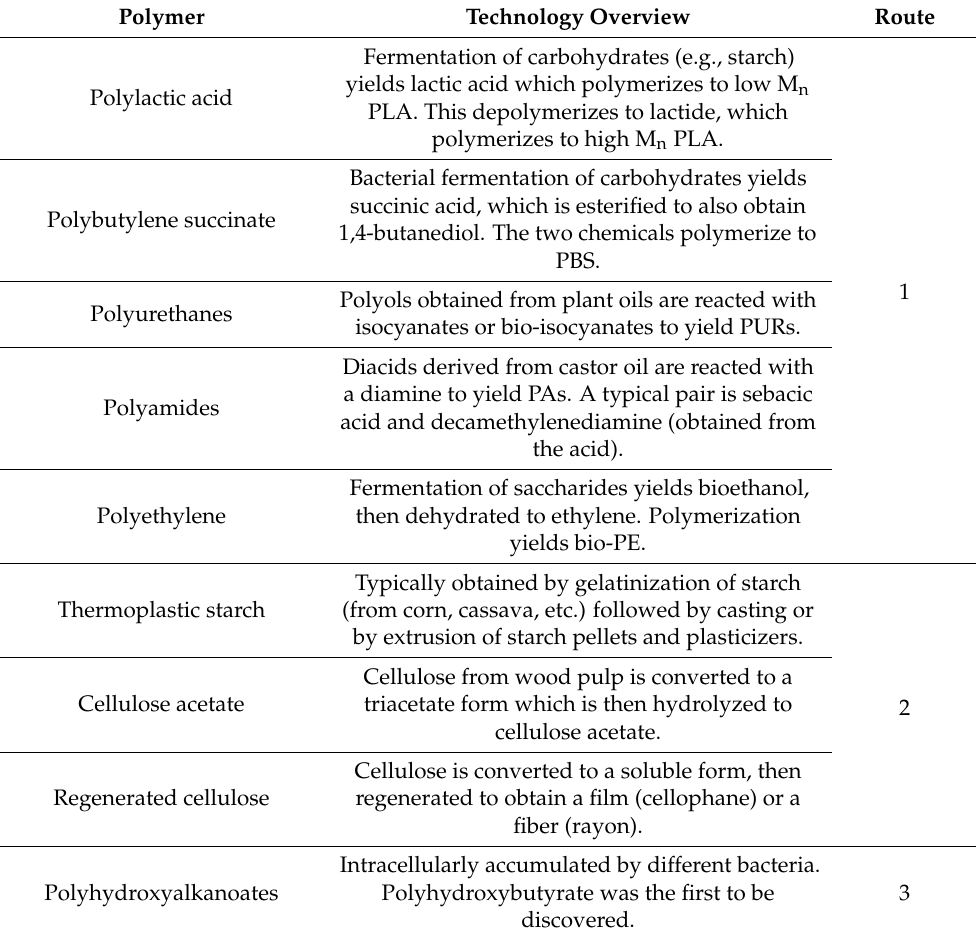
Table 2. List of common bio-based polymers and overview of their